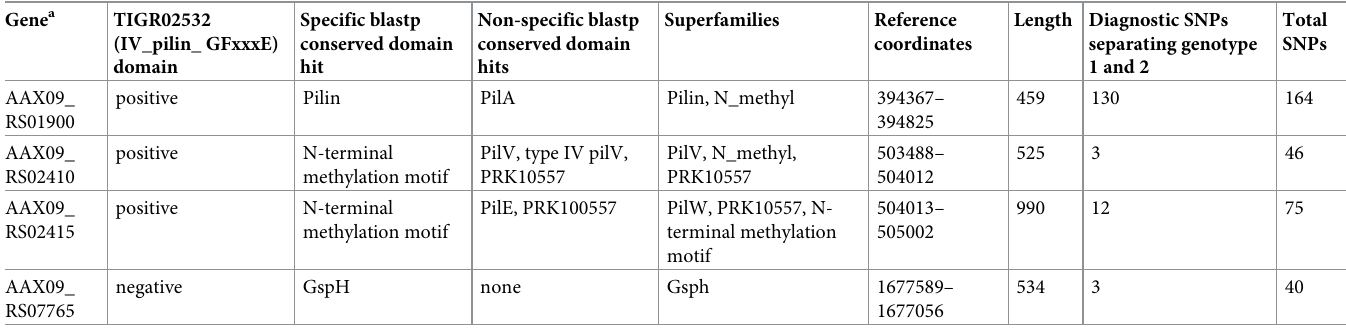
Table 3. Characteristics of four pilin-like genes in M . bovoculi